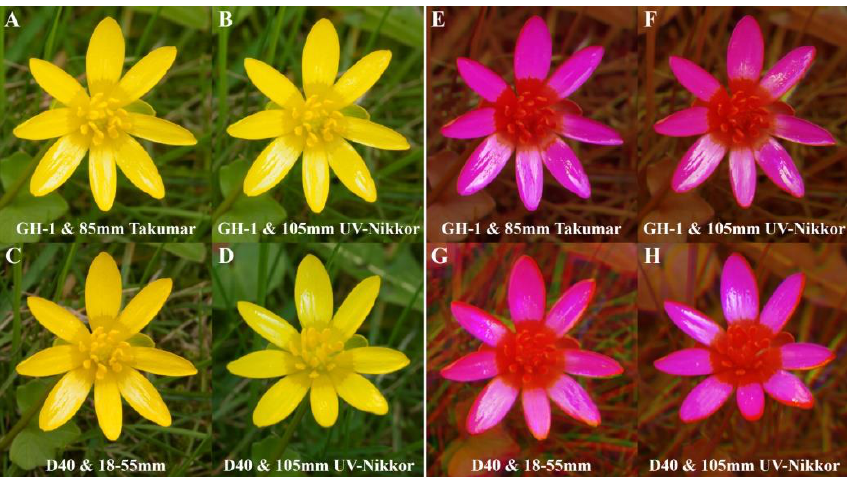
F IGURE 23. Colour pictures (A-D) and false-colour pictures (E-H) of the Pilewort Ficaria verna L. (Ranunculaceae) taken with different camera equipment which was Panasonic GH-1 camera and Pentax 85 mm Ultra Achromatic Takumar lens (A, E), Panasonic GH-1 camera and 105 mm